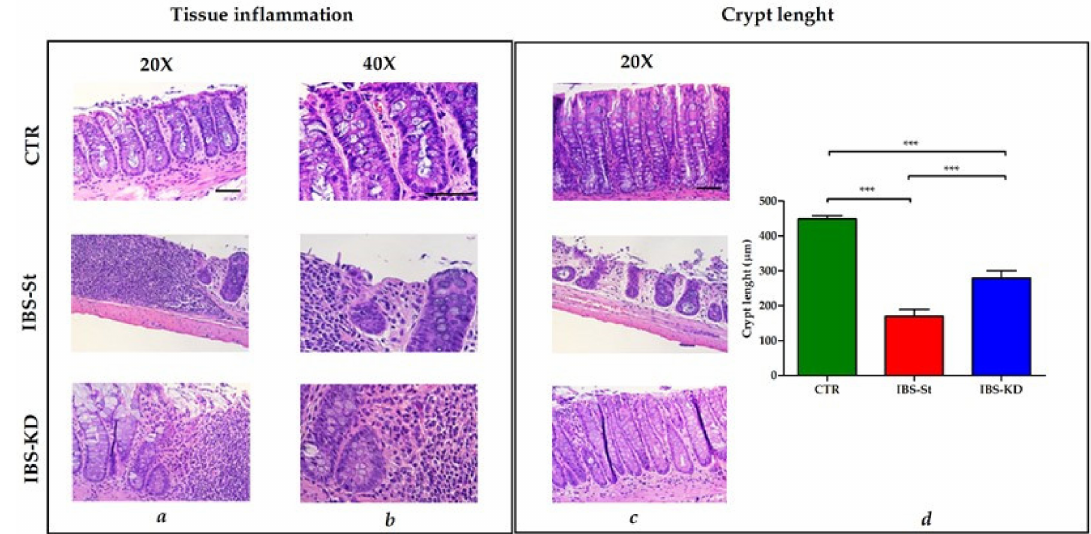
Figure 1. Hematoxylin and eosin staining of distal intestinal tract section from three experimental groups, control group (CTR, n ◦ 12 animals), IBS rats fed a standard diet (IBS-St, n ◦ 11 animals), and IBS rats treated with low-carbohydrate, high-fat ketogenic diet (IBS-KD, n ◦ 17 animals). ( a ) Magnification 20 × and ( b ) magnification 40 × , scale bars 50 µ m. ( c ) Magnification 20 × , scale bar 50 µ m, shows intestinal crypt length in the control group (CTR), IBS rats fed a standard diet (IBS-St), IBS rats treated with low-carbohydrate, high-fat ketogenic diet (IBS-KD). ( d ) Crypt length in the graph; results represent the mean ± SD (one-way ANOVA with Tukey’s multiple comparison test *** p < 0.0001).